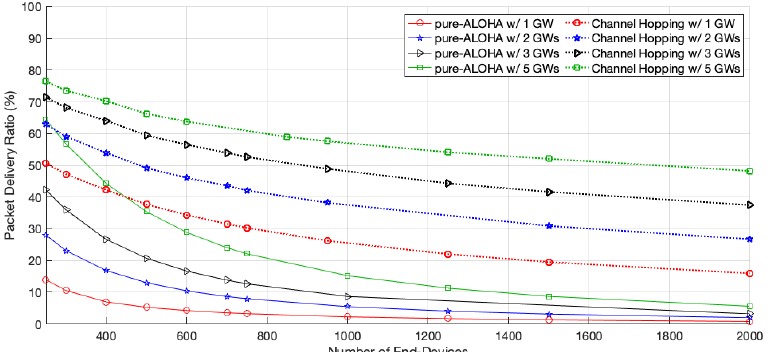
Figure 5. Network packet delivery ratio (PDR).